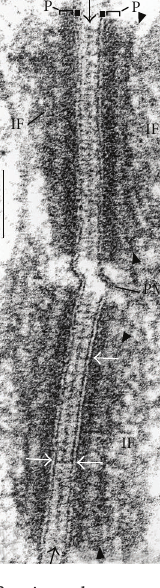
Figure 1: High-magnification electron micrograph of two cross sectioned desmosomal structures connecting stratum spinosum cells of human fetal (20wk) foot-sole epidermis. Brackets and label “P”: cytoplasmic dense plaque; black arrows: midline structure; white arrows: trilaminar “unit membrane” structure of the plasma membrane; arrowheads (top and bottom): secondary dense layer of the plaque; IF: intermediate-sized filaments (for further details see [7]); PM: plasma membrane. Bar: 0.1 μ m.